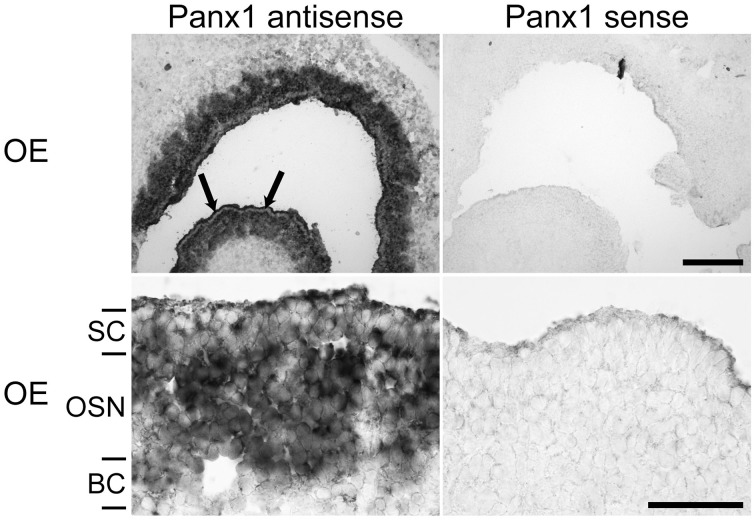
In-situ hybridizations with riboprobes specific for Panx1.
In-situ hybridizations from juvenile mice (P7) with Panx1 riboprobes. Panx1 antisense probes delivered strong labeling in the OE. Strong staining in the OE was present in the OSN layer. Weaker staining of SCs was more obvious in the overview (upper left, indicated by arrows). The BC layer showed weaker staining than the OSN layer. Scale bars = 200 μm, and 100 μm (close-up, middle) (OE, olfactory epithelium; SC, sustentacular cells; OSN, olfactory sensory neuron; BC, basal cell layer).